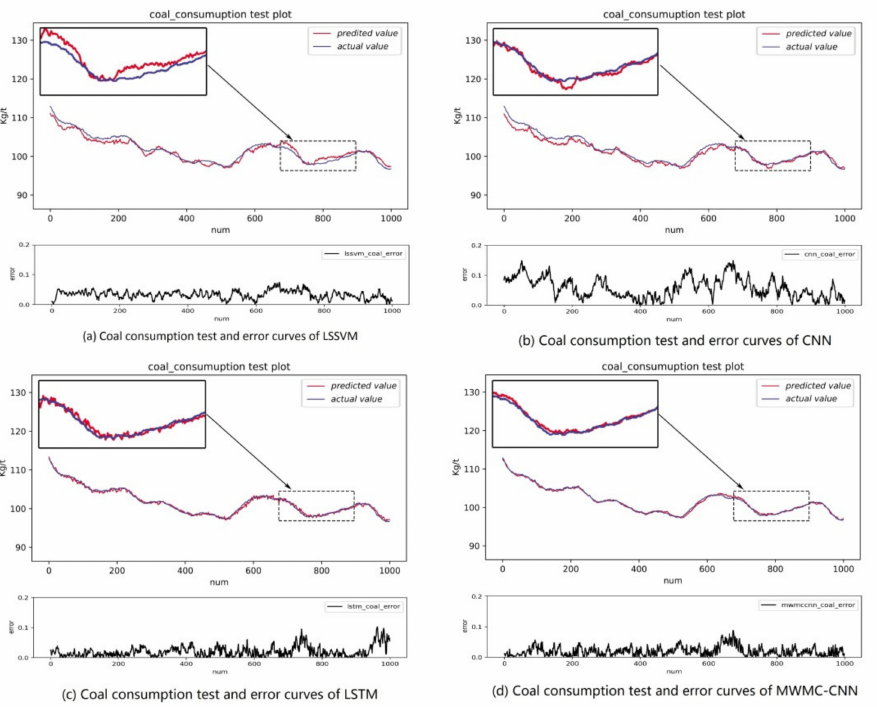
Figure 10. Coal consumption test and error curves of LSSVM, CNN, LSTM and